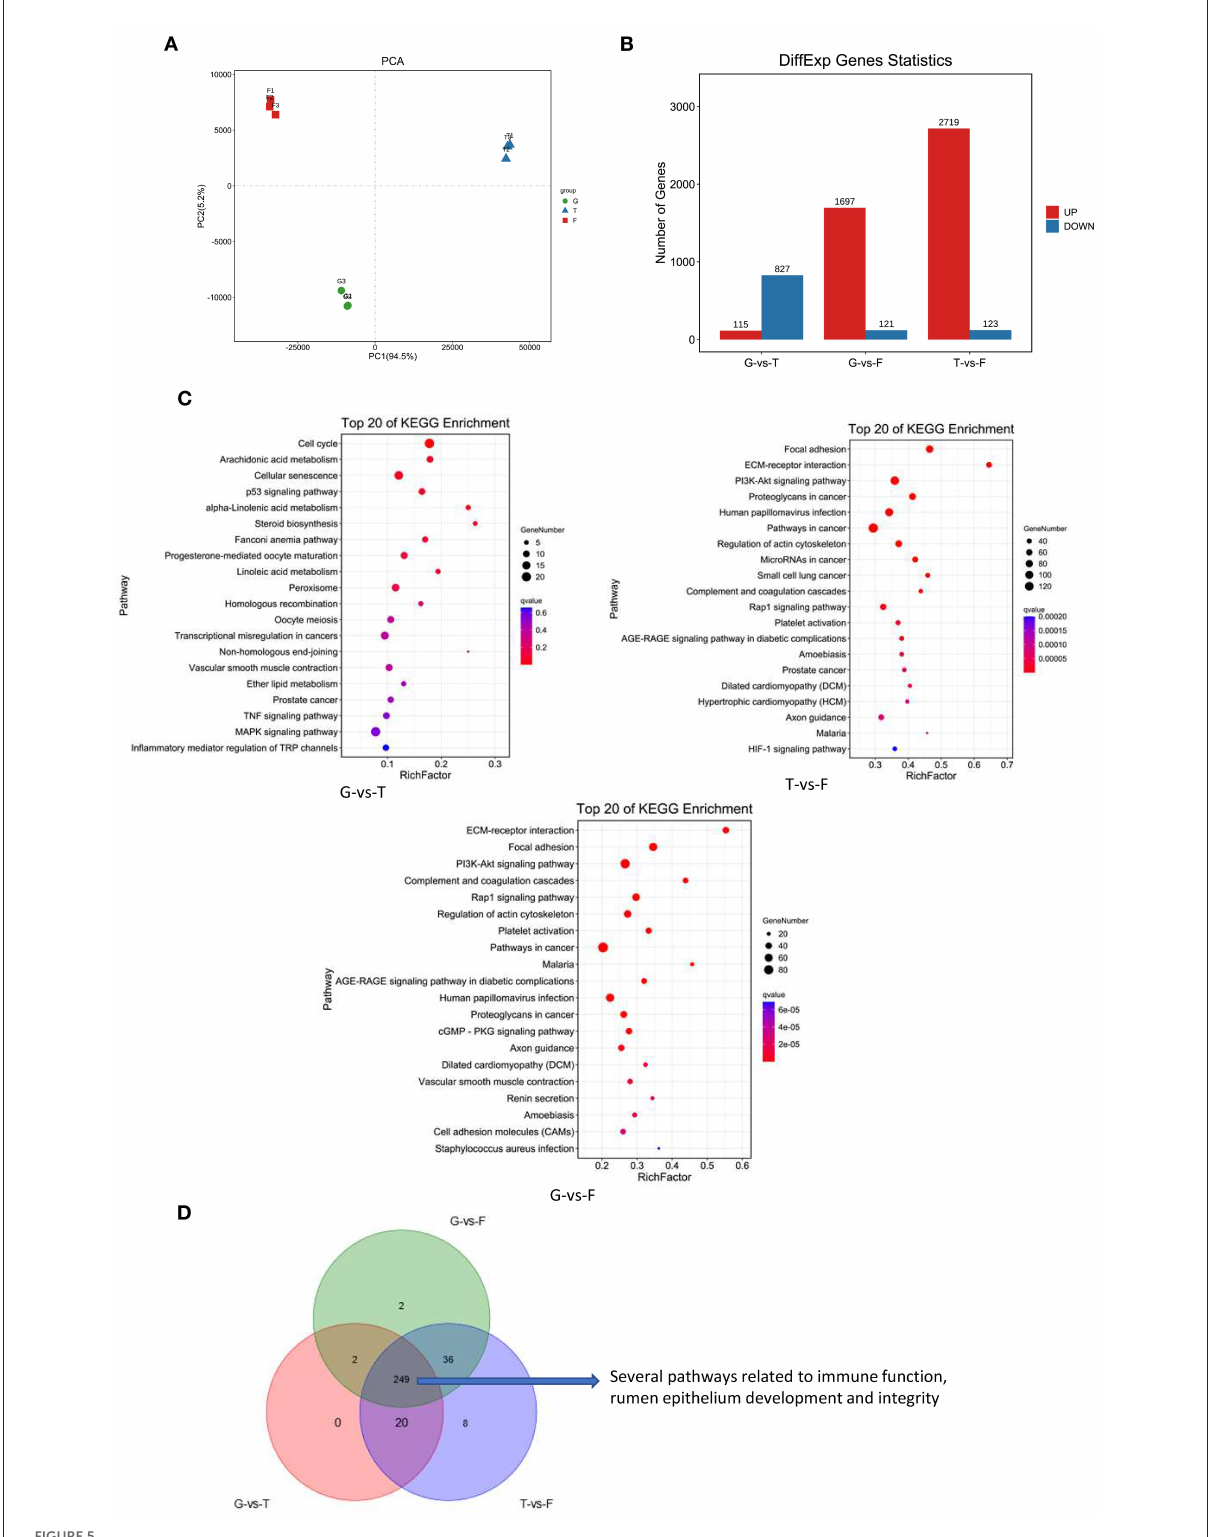
FIGURE5 Overview of Gangba sheep ruminal epithelium transcriptome under different feeding strategies. (A) PCA plots of transcripts identified by RNA-Seq of Gangba sheep under natural grazing (G), semi-grazing with supplementation (T), and barn feeding (F) conditions . (B) Number of individual transcripts significantly up- or down-regulated under different feeding strategies . (C) KEGG pathway enrichment analysis of DEGs in